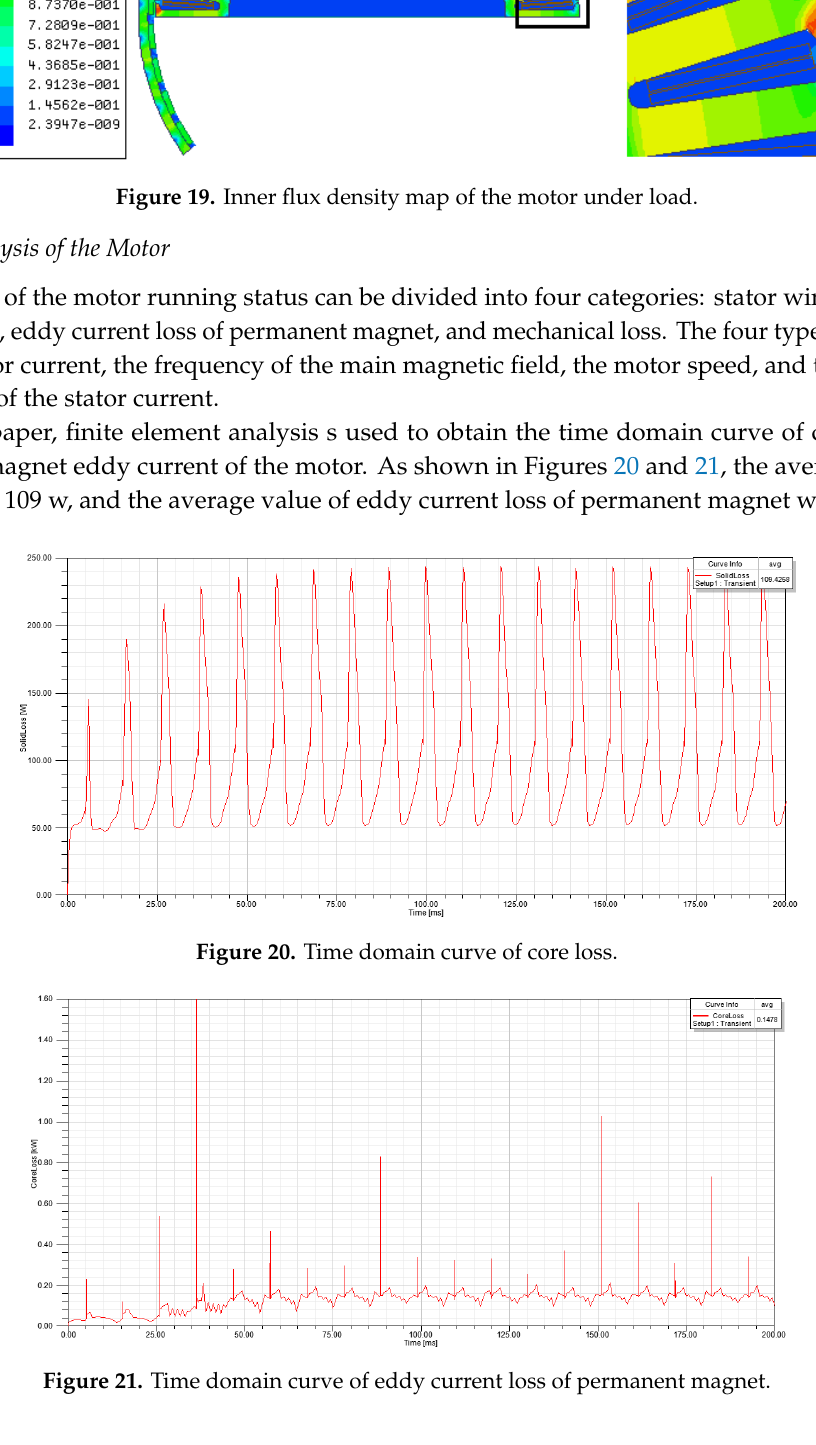
Figure 19. Inner flux density map of the motor under load.